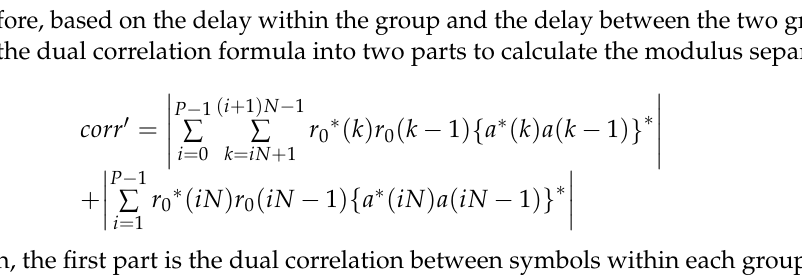
Figure 7. Two different kinds of time delays in r 0 ∗ ( k ) r 0 ( k − 1 )